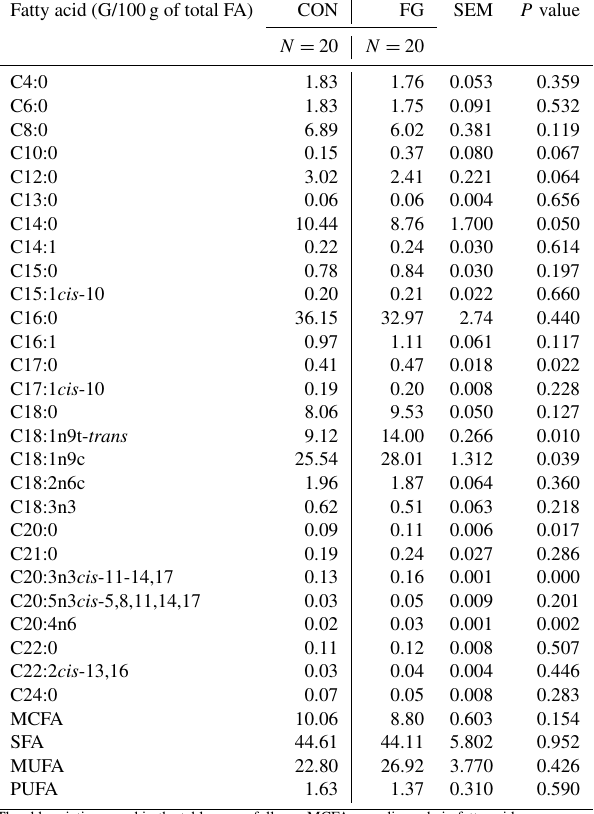
The abbreviations used in the table are as follows: MCFA – medium-chain fatty acids (C8:0 + C10:0 + C12:0), SFA – saturated fatty acids